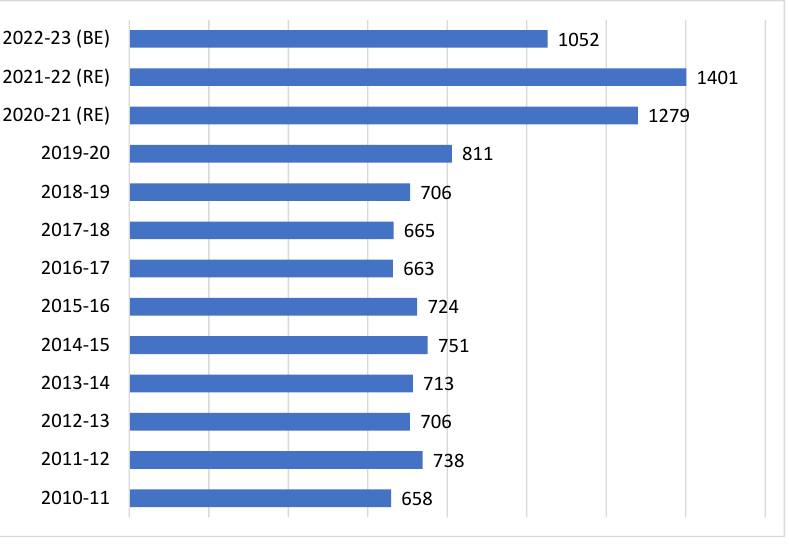
Figure A1. Total Subsidy on all Fertilizers from 2010–2011 to 2021–2022 (Billion INR). (BE—Budget Estimate, RE—Revised Estimate). Table A1. ANOVA result of yield comparison for black gram in Andhra Pradesh.